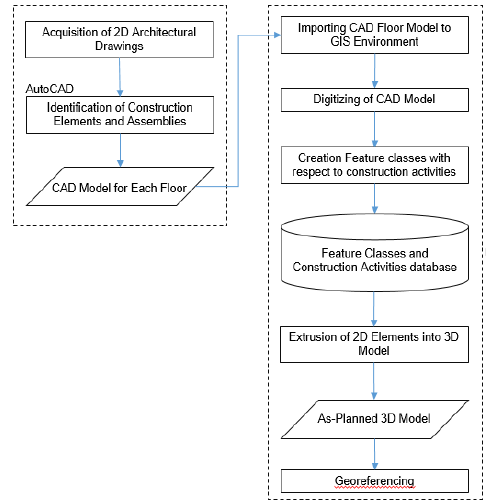
Figure 1. As-planned 3D model generation schema